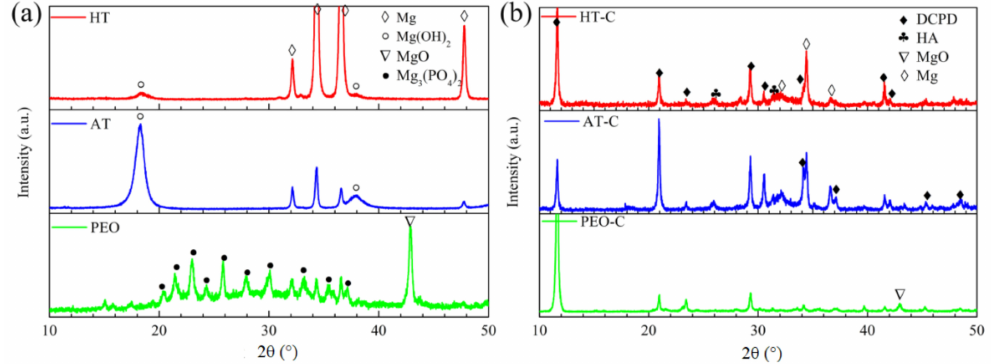
Figure 1. X-ray di ff raction patterns of the pre-treated and CaPh-coated substrates: ( a ) pretreated samples; ( b ) CaPh coated